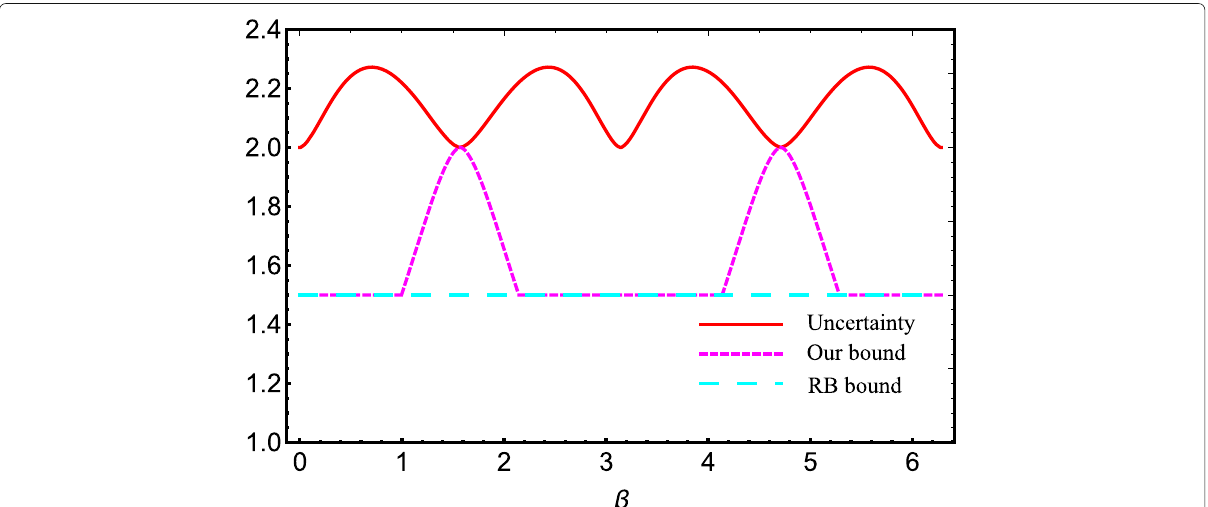
Fig. 2 Uncertainty and the lower bounds vs the W-type state parameter . Red solid line denotes the quantity of the entropy-based uncertainty (right-hand side of Eq. (13)), magenta dashed line denotes our result (right-hand side of Eq. (15)) and cyan dashed line denotes Renes-Boileau’s result for four-qubit (right-hand side of Eq. (13))